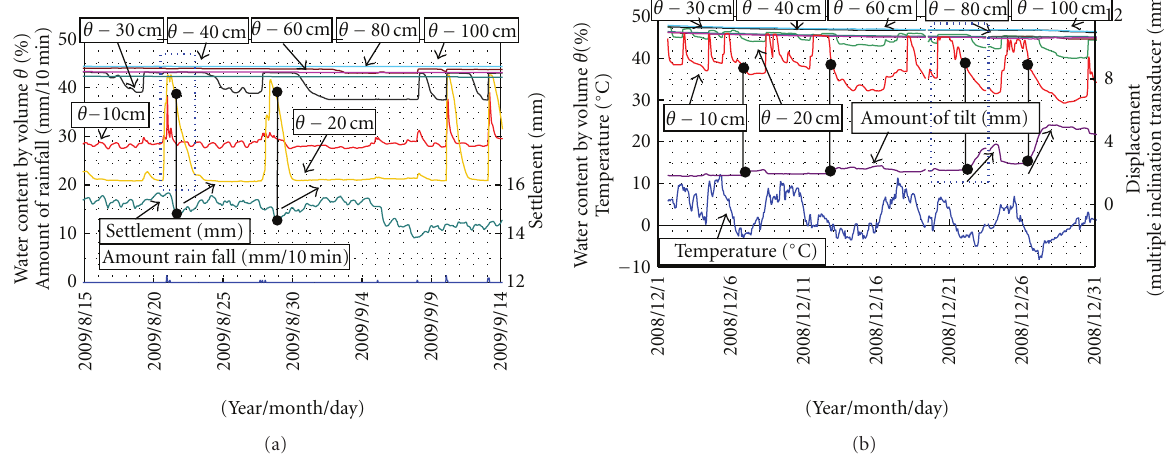
Figure 15: Changes in water content by volume, θ ; (a) in summer season, and (b) in winter season.